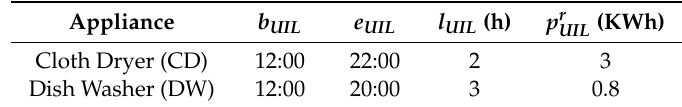
Table 2. Parameters of uninterruptible loads.